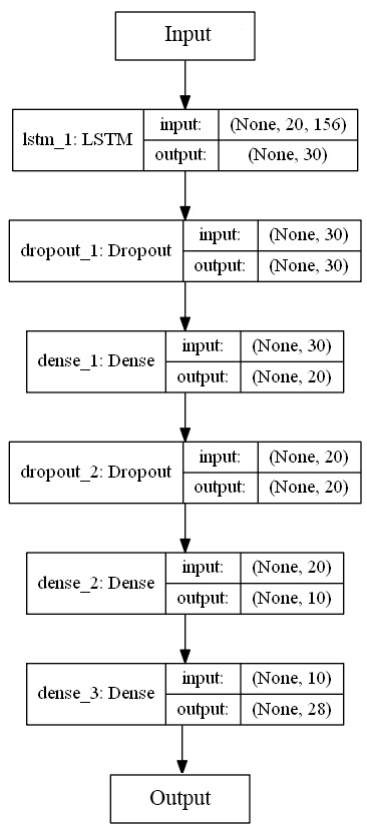
Figure 10. Optimized configuration of the RNN 5